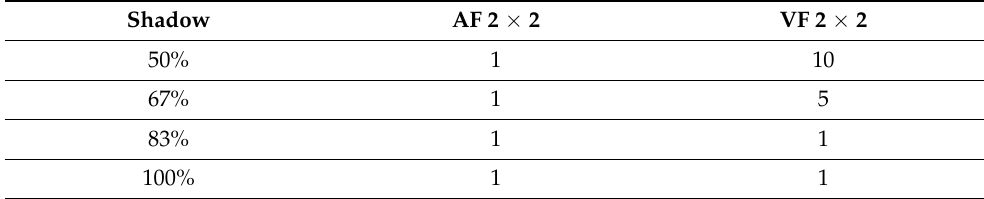
Table 3. Recognition time (s) AR Foundation (AF) vs. Vuforia (VF).